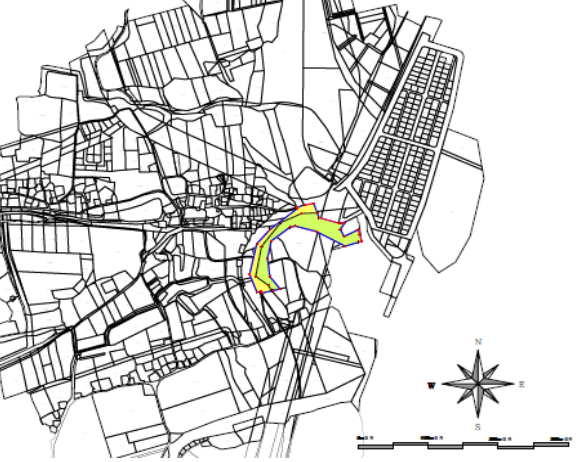
Figure 7. Overlap of Cadastral Map with flooding area map